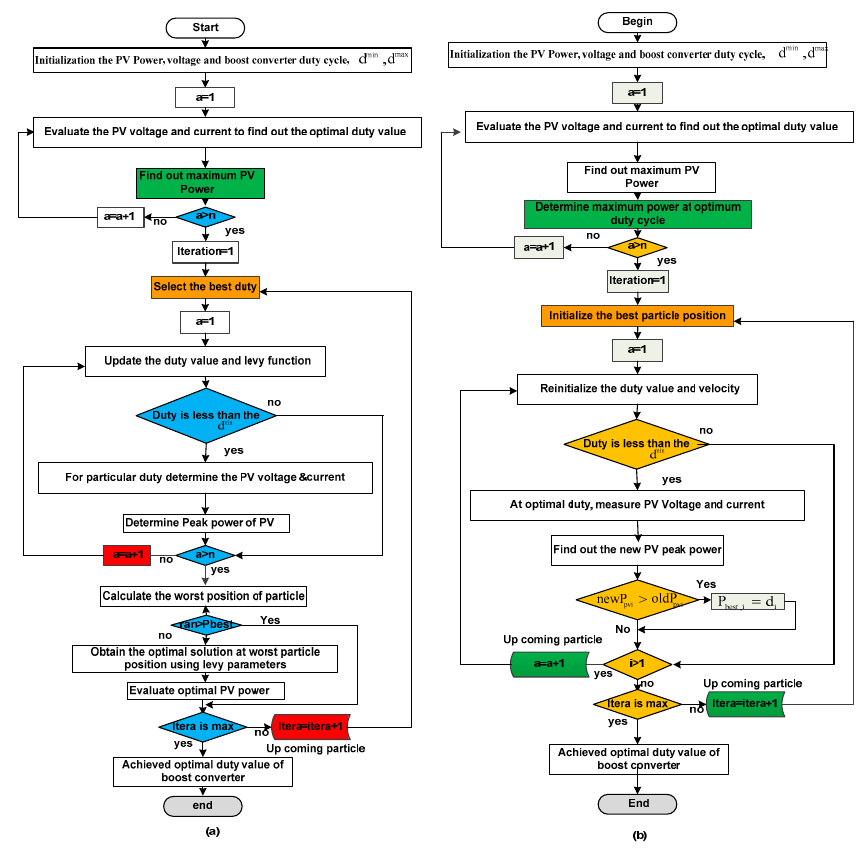
Figure 10. Flowchart for ( a ) particle swarm optimization (PSO) [41] and ( b ) cuckoo search MPPT techniques